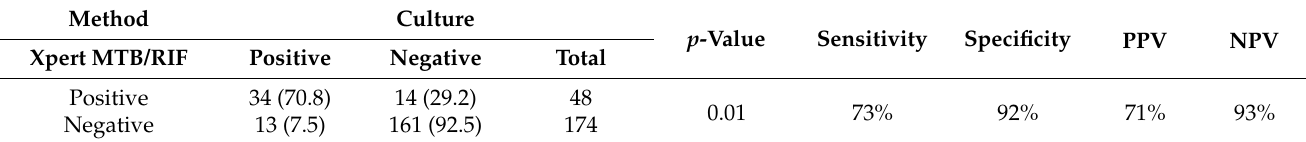
Table 3. Comparison of Xpert MTB/RIF with reference to culture.